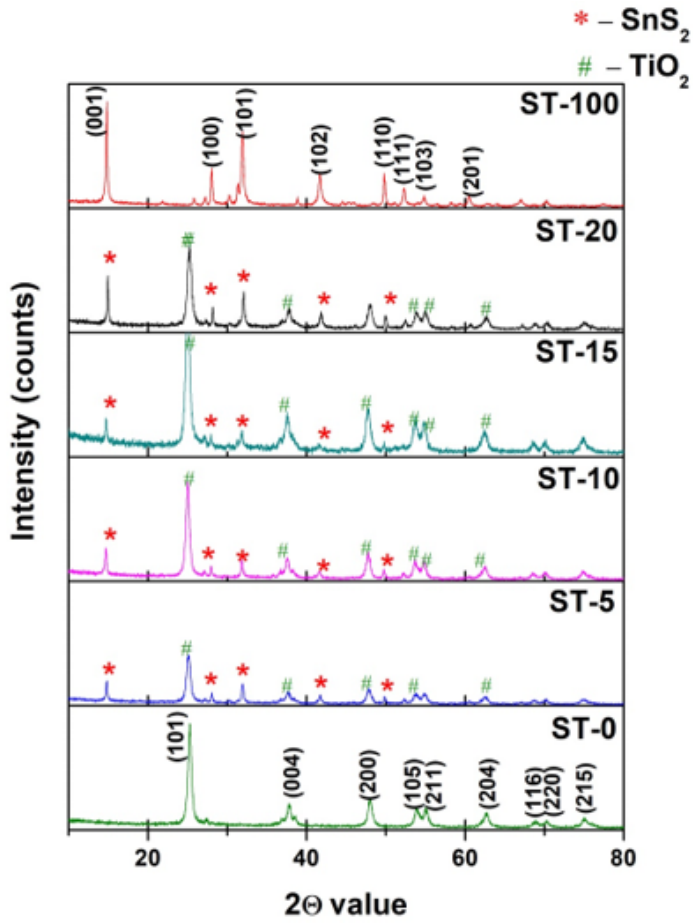
Figure 17. XRD image for pure SnS 2 (ST-100), pure TiO 2 (ST-0), different wt. % of SnS 2 /TiO 2 materials 5% (ST-5), 10% (ST-10), 15% (ST-15), and 20% (ST-20). Reproduced with permission from [106].